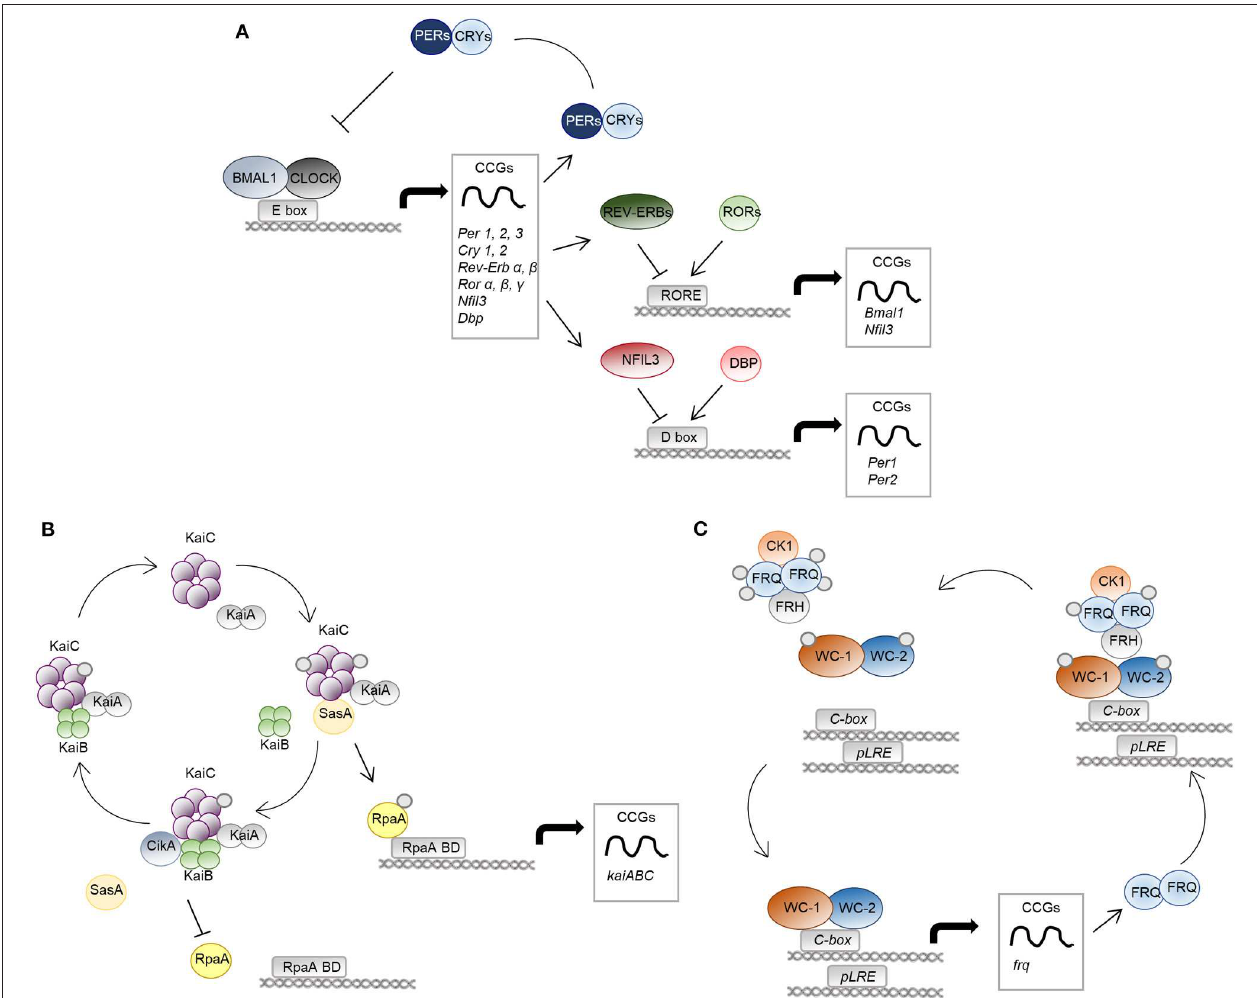
FIGURE 1 | The molecular clock in mammals, bacteria and fungi. The molecular mechanisms of the circadian clock in mammalian cells (A) , S. elongatus (B) , and N. crassa (C) are schematically represented. (A) The positive regulators CLOCK-BMAL1 activate transcription of genes with E-box elements in their promoters, named clock-controlled genes (CCGs). Among them, there are regulators of the negative limb (PER and CRY proteins) as well as other transcription factors, such as REV-ERBs/RORs and DBP/NFIL3, controlling the expression of genes with RORE and D-box DNA-response elements in their promoter, respectively. (B) , KaiA binds KaiC hexamers and promotes its phosphorylation. The protein SasA competes with KaiB for the binding to phosphorylated KaiC. SasA binding induces activation of the output protein RpaA, controlling global gene expression through RpaA DNA binding domains (RpaA BD). Accumulation of KaiB and binding to KaiC causes inactivation of KaiA, leading to KaiC dephosphorylation and inactivation. Moreover, CikA interacting with KaiB cause dephosphorylation and inactivation of RpaA. (C) The positive elements of the WCC complex (WC-1 and WC-2) control the circadian expression of the frequency ( frq ) gene, the negative arm of the feedback loop. FRQ homodimers associate to the protein FRH and to casein kinase 1 (CK1), causing phosphorylation and inactivation of WCC. Progressive phosphorylation of FRQ leads to dissociation from the WCC complex and proteasomal